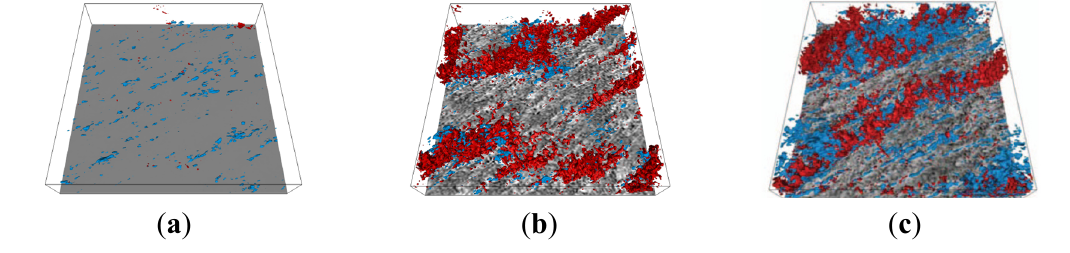
Figure 4. Iso-surfaces of instantaneous streamwise (blue, − 1 . 25 m/s) and vertical (red, +1 . 00 m/s) velocity fluctuations in atmospheric boundary-layer precursor simulations (OpenFOAM-LES) . ( a ) NBL ( z 0 = 0.001 m); ( b ) MCBL ( z 0 = 0.001 m); ( c ) MCBL ( z 0 = 0.2 m).